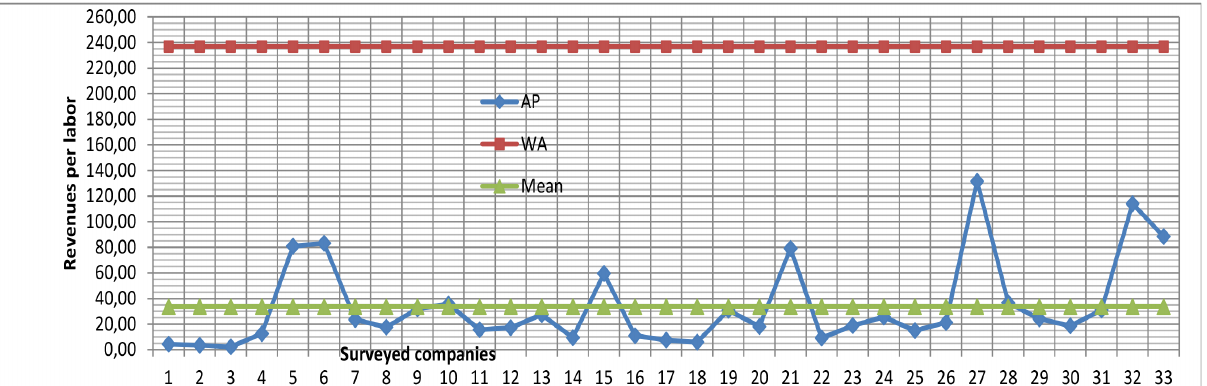
Figure 2. Line chart to show gap between actual performance and world average in revenues per